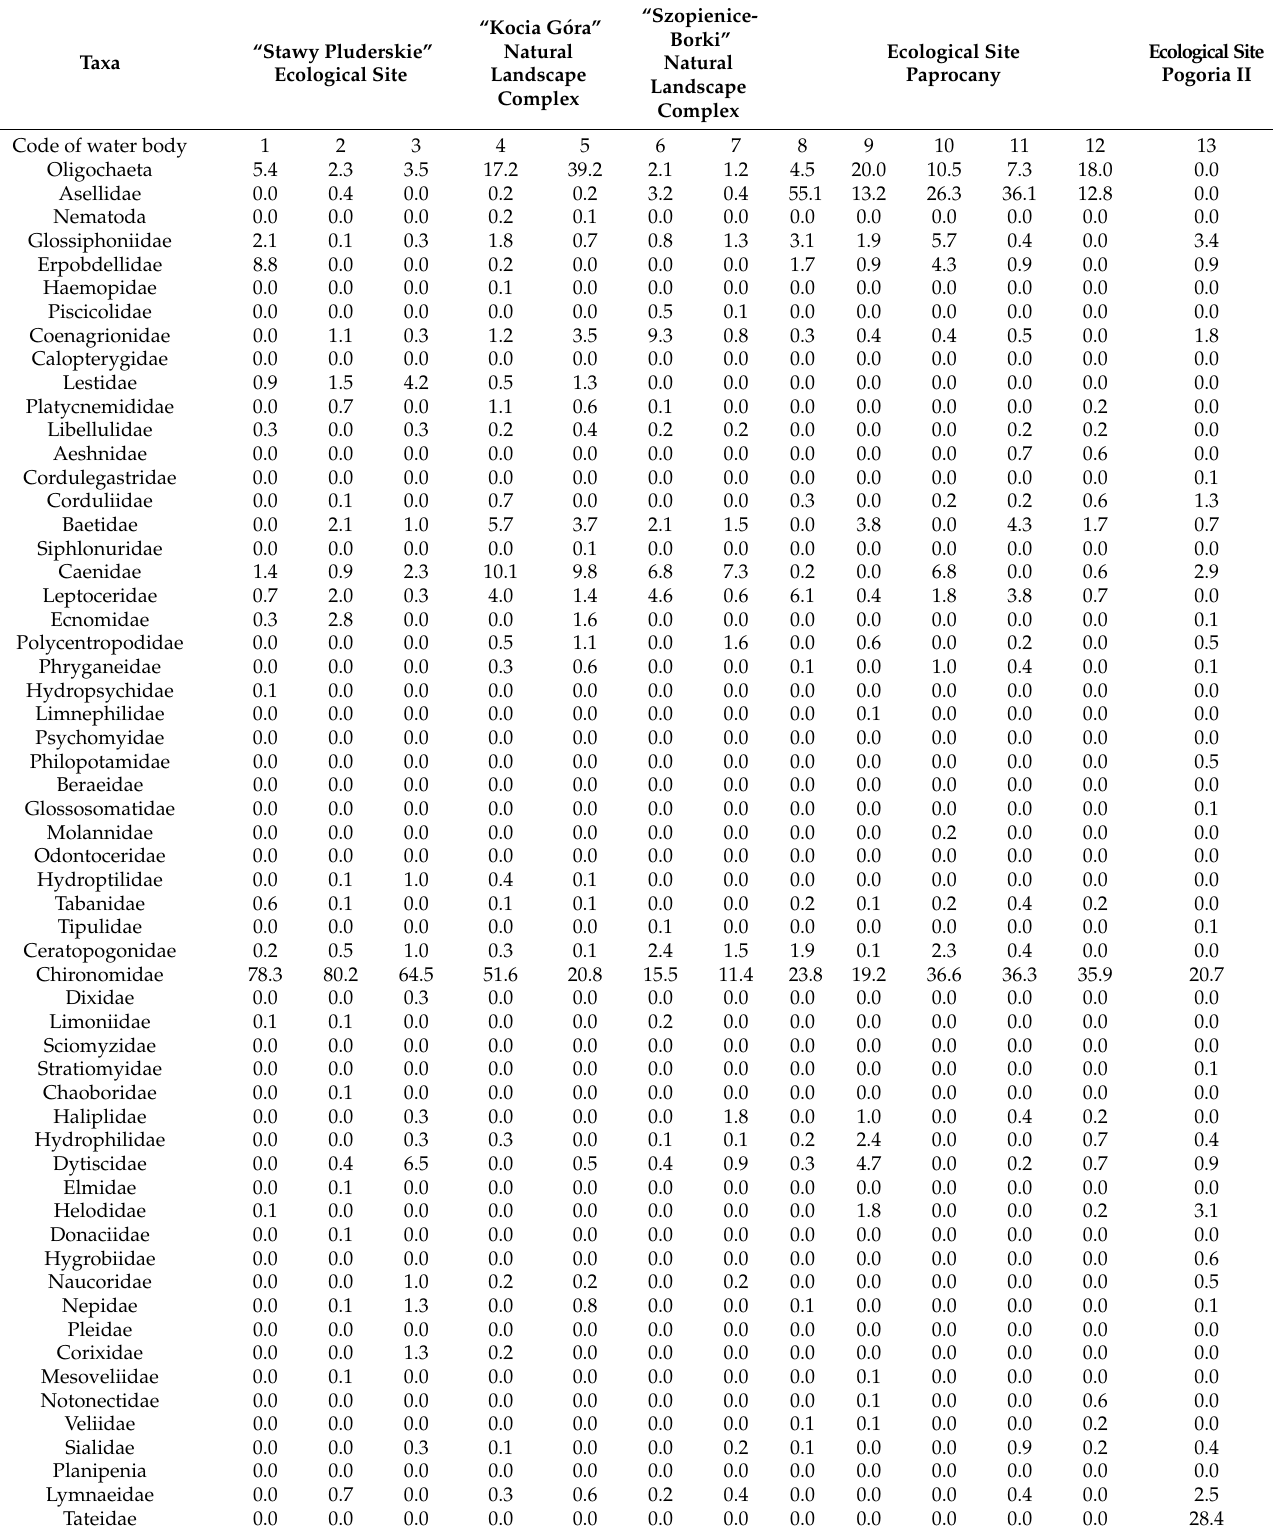
Table 3. Macroinvertebrate taxa (the percentage of fauna) in the studied water